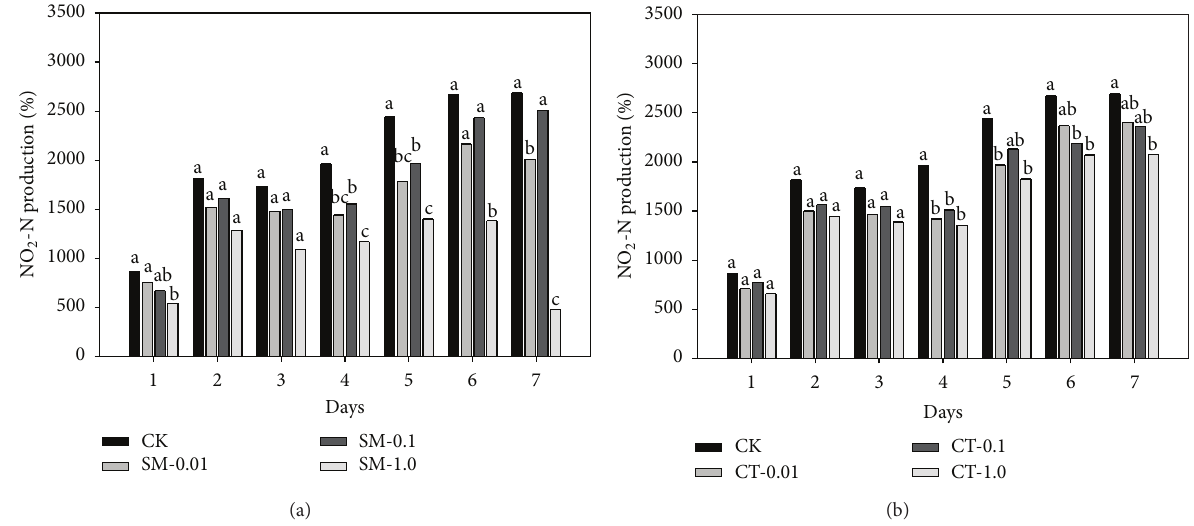
Figure2:Comparisonofnitrite(NO 2 -N)productionovertimeingroundwaterunderdenitrifyingconditionsintheabsence(CK)orpresence of (a) sulfamethazine (SM-0.01, -0.1, and -1.0mg/L) and (b) chlortetracycline (CT-0.01, -0.1, and -1.0mg/L). Same letters above each bar indicate no difference between different treatments at a 0.05 significance level of the Tukey’s studentized range test.